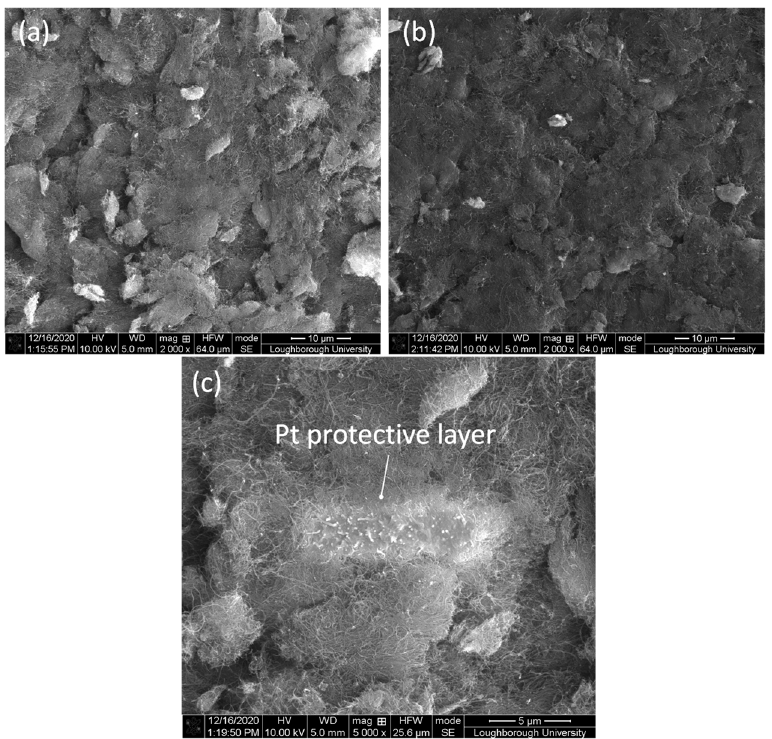
Figure 11. SEM images of the PCBN samples coated with CNTs: ( a ) condition A, ( b ) condition G, ( c ) higher resolution image of platinum coating for condition A. All images were taken in top view.